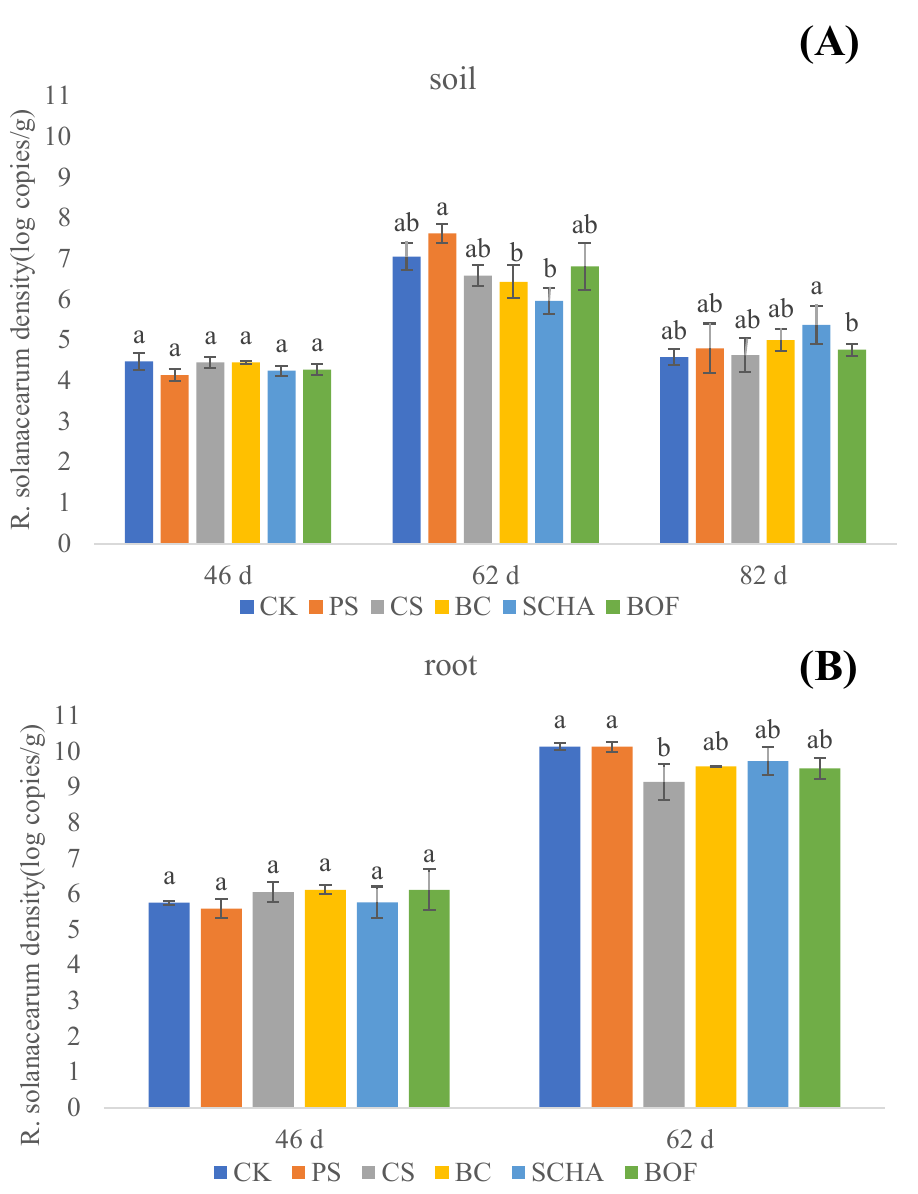
Figure 2. The number of R. solanacearum in the soil ( A ) and roots ( B ) of different treatments at 46 d, 62 d, and 82 d. Different letters represent significant differences among different treatments at the same transplanting. Bars indicate the standard error ( n = 4). Amendment treatments include CK (no fertilization); PS (potassium silicate); CS (calcium silicate); BC (biochar); SCHA (calcium silicate humic acid); BOF (bio-organic fertilizer).